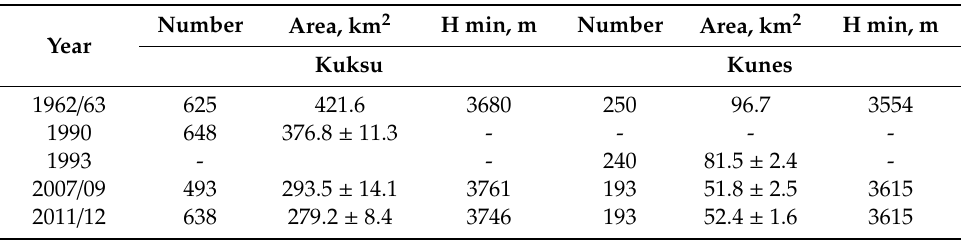
Table 4. Changes in glacier number, total area, and minimum elevation of glacier tongues averaged over the